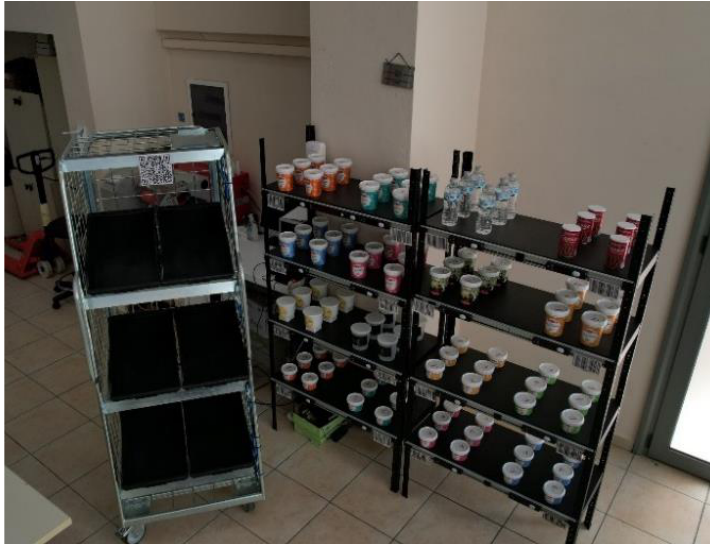
Figure 7. Laboratory equipment.